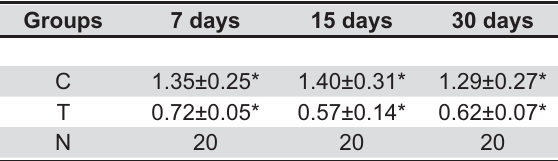
* Significant difference intergroup the same period (p<0.05). ANOVA and Tukey